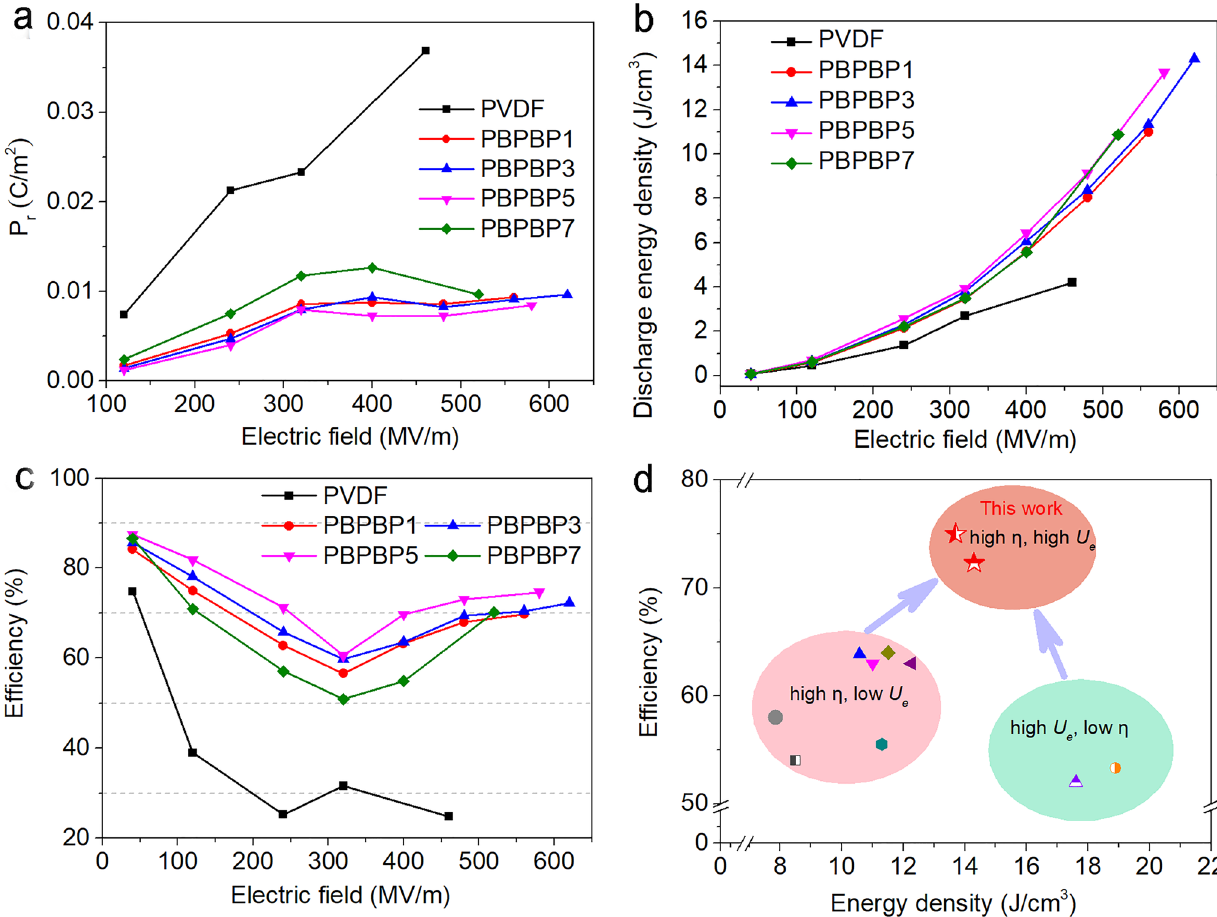
Fig. 5 a The remnant polarization ( P r ) as a function of electric field, b discharged energy densities and c charge–discharge efficiencies as a function of electric field of PVDF and PBPBP films. d Comparison of efficiency and maximum discharged energy density of PBPBP3 and PBPBP5 with previous reported results [57, 60,